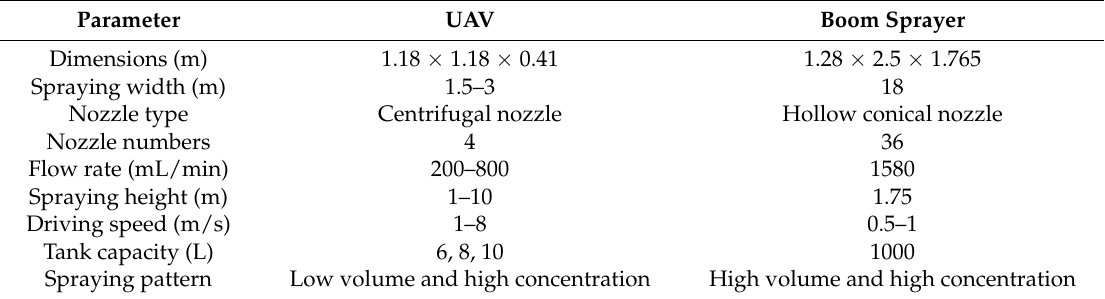
Table 1. Characteristic parameters of UAV and boom sprayer.